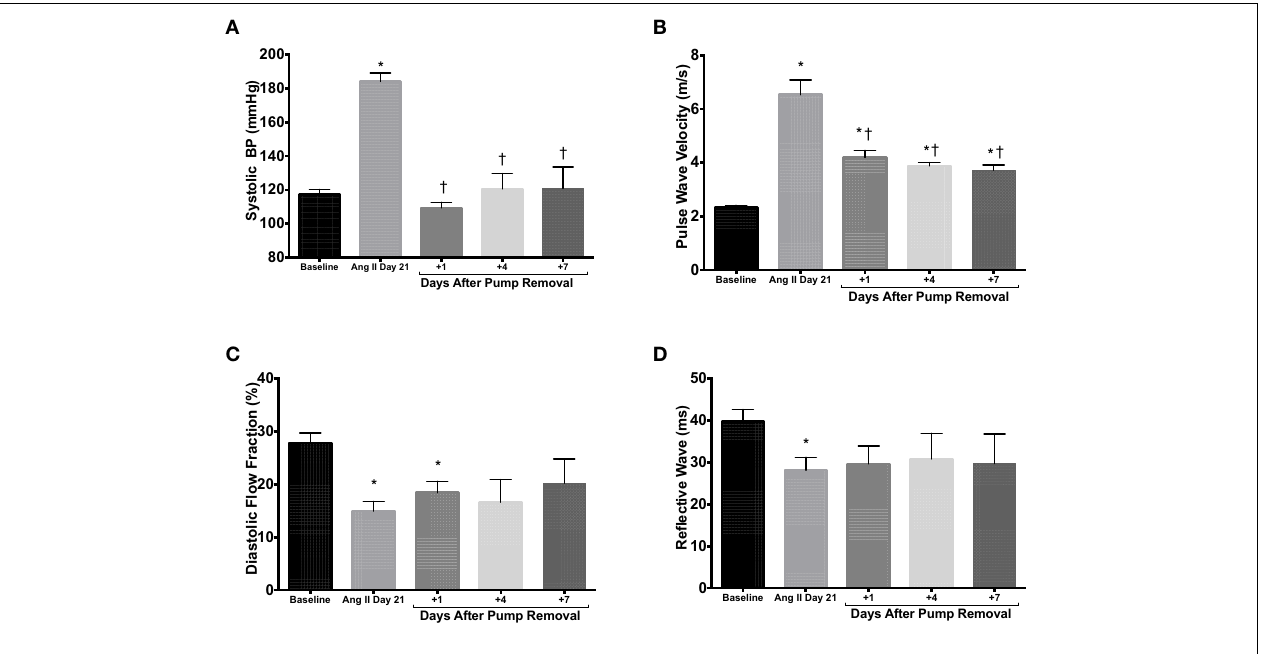
of PWV (B) , diastolic flow fraction (C) , and reflective wave (D) were also measured. * P < 0 . 05 vs. day 0; † P < 0 . 05 vs. day 21. N = 4 –6. Data are means ± SEM.